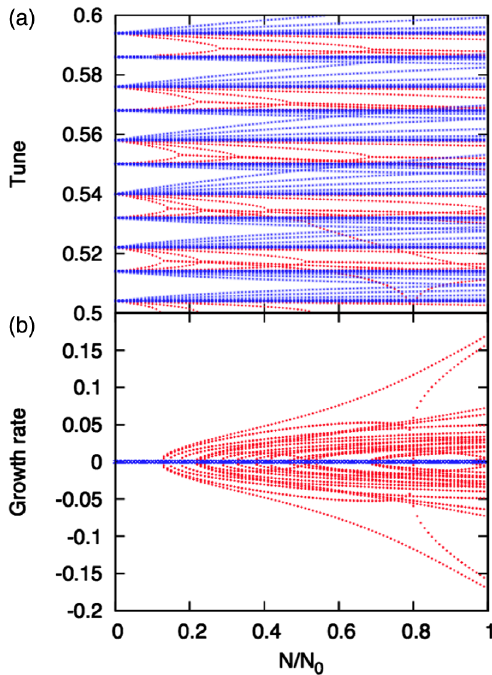
FIG. 14. Eigenvalues of σ and π modes as a function of the bunch population ( N ) for FCCee-Z parameter, where ξ The tune and growth rate for scanning the bunch population N ð(cid:2)Þ ¼ 0 − N 0 are plotted in (a) and (b). Red and blue points are used for the σ and π modes,